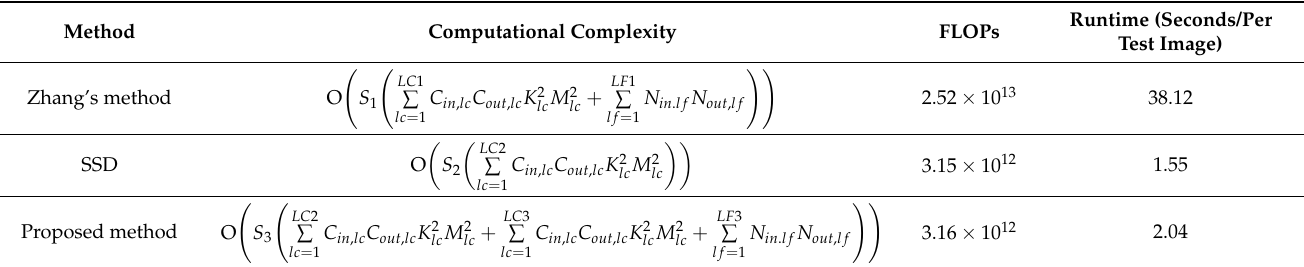
Table 3. Complexities of the proposed method and other CNN-based detection